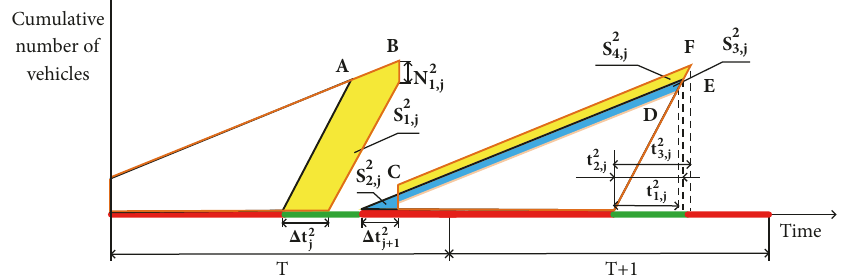
Figure 4: Calculation of vehicular delay for movement j in scenario 2.